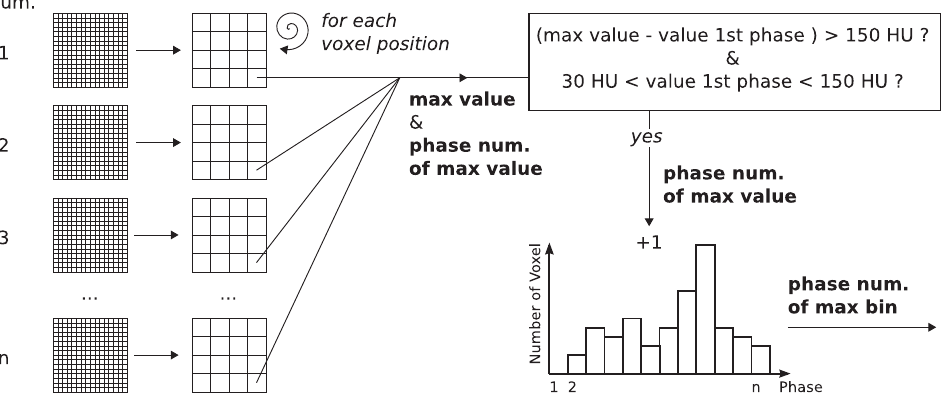
Fig. 1. Flowchart for the findLV algorithm. First, the images are shrunk. Second, the maximum value over all phases and the corresponding phase number are evaluated for each voxel position. The maximum value has to have an increase of at least 150HU compared to the voxel in the first phase. Furthermore, the value in the first phase has to be between 30 and 150HU for each voxel position. If both conditions are fulfilled, the phase number is entered in the phase histogram. The phase with the maximum number of voxels in the phase histogram will be selected as the detected